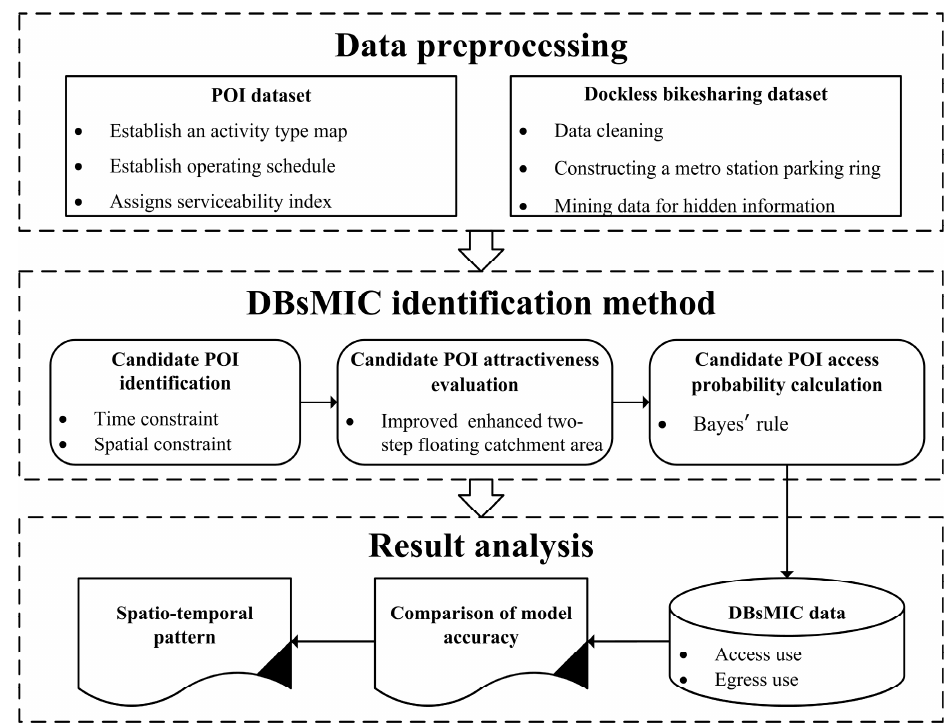
Figure 2. Frameworks and workflows.